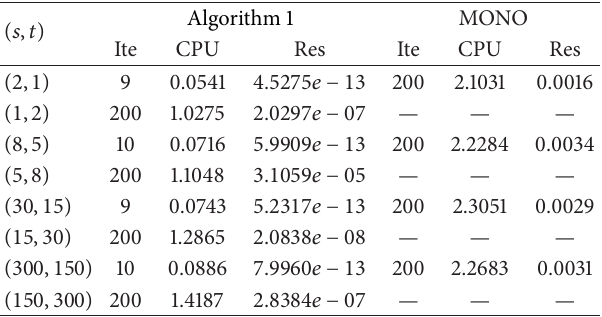
Table 1: Iteration, CPU time (seconds) and residue for solving (1) with 𝑠 ̸=𝑡